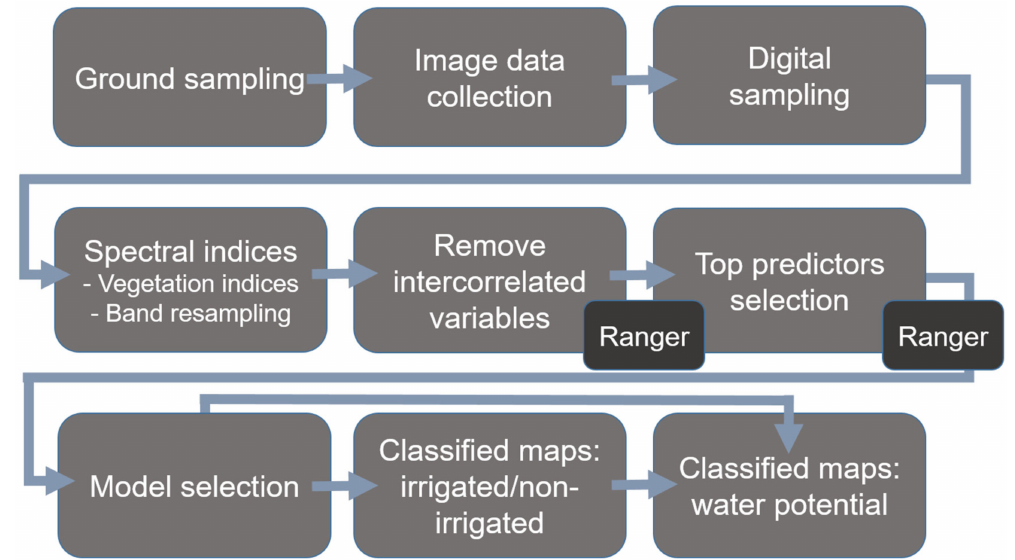
Figure 2. Process flow from data collection to classified and predicted